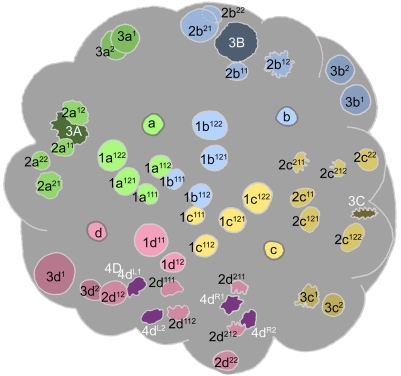
54-cell embryo, 635 minutes.2c12 and 2c21 have just divided; the corresponding cells in the 2d lineage are in telophase, and those in the 2a lineage are between metaphase and anaphase. 2b12 is in prometaphase, and 2b21 has not entered mitosis. Mitoses are beginning in the 3ABC cells, while the left and right daughters of 4d have just divided. The 3c1 cell is in metaphase. The outline of the 4D cell is not shown in this drawing.